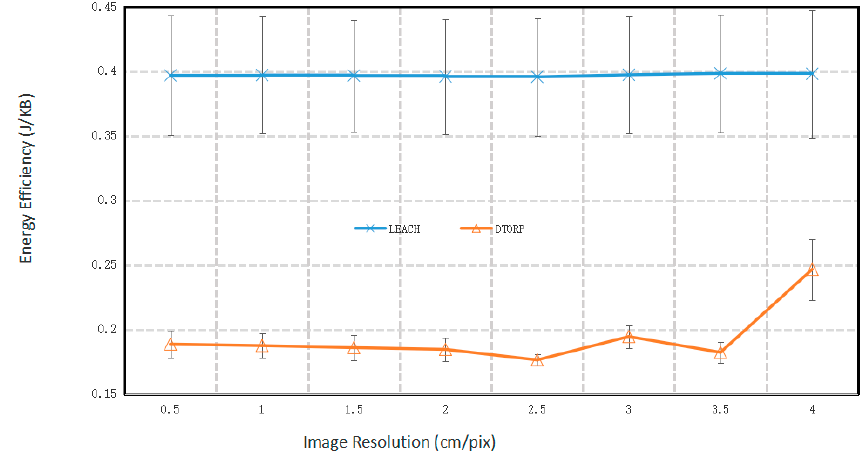
Figure 3. Energy efficiency of the UAV-WSN systems with respect to the spatial image resolution. Figure 3. Energy e ffi ciency of the UAV-WSN systems with respect to the spatial image resolution.